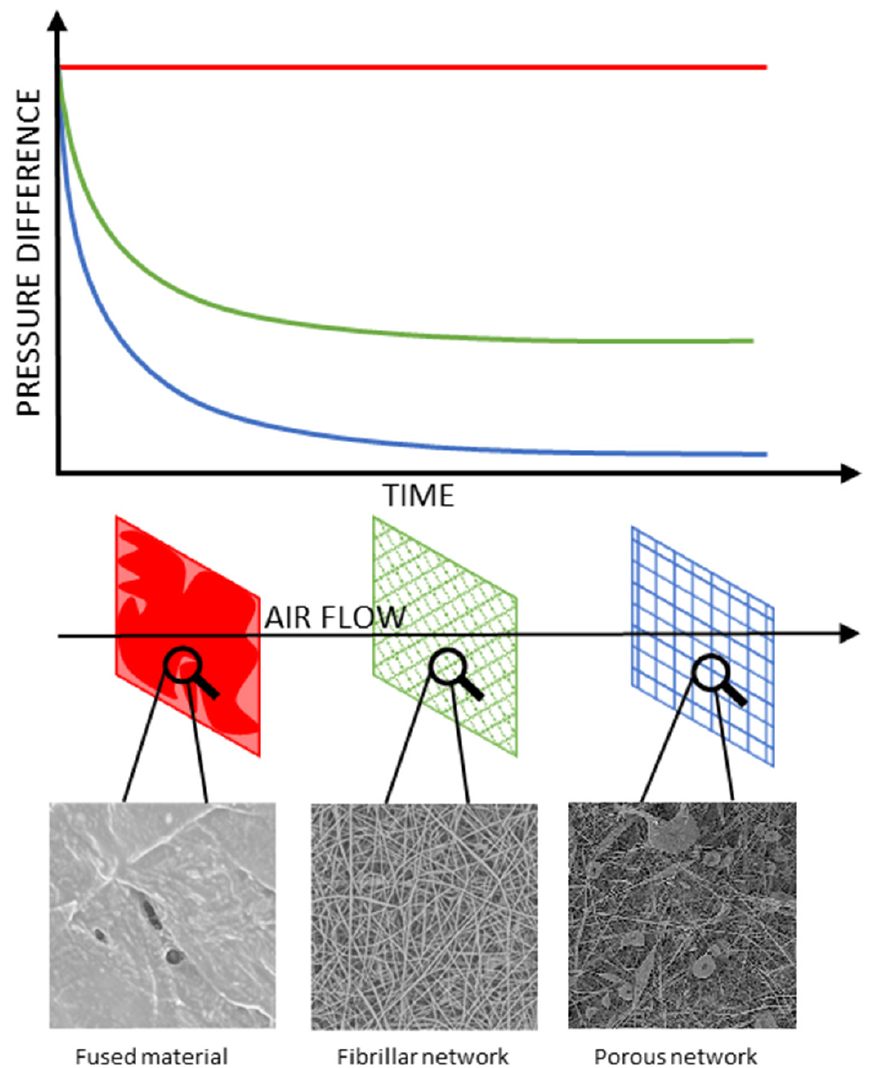
Figure 7. The microstructure–flow permeability relationship for the studied electrospun mem- branes.